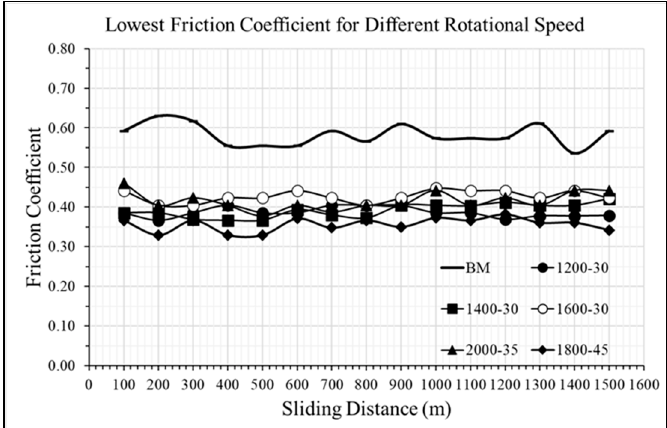
Figure 13. Sliding friction coefficient vs. sliding distance for FSPed samples with lowest friction coefficient produced by different processing parameters under starved lubrication conditions. (Normal contact pressure = 0.24 MPa, sliding speed = 2.88 m/s, total sliding distance = 1500 m).